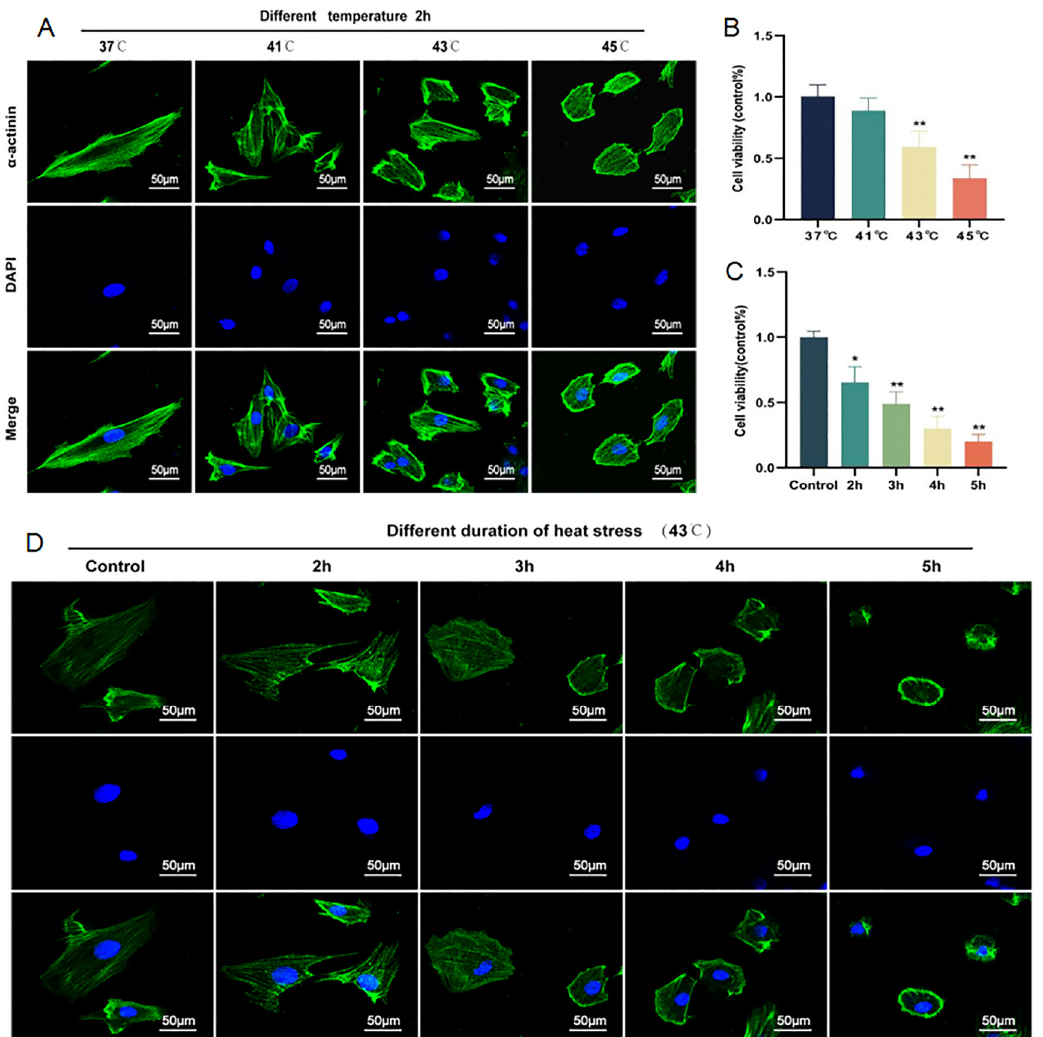
Figure 1. Morphological and viability changes in H9C2 cells. Cell morphology of H9C2 cells at different temperatures (37 °C, 41 °C, 43 °C and 45 °C) for 2 h. Scale bars = 50 µm. ( A ). Cell viability of H9C2 cells at different temperatures for 2 h via a CCK-8 assay ( B ). Cell viability of H9C2 cells at 43 °C for different duration (2 h, 3 h, 4 h, and 5 h) via a CCK-8 assay ( C ). Cell morphology of H9C2 cells at 43 °C for a different duration. Scale bars = 50 µm. ( D ). The staining was performed by FITC-conjugated α -actinin and DAPI and observed by confocal fluorescence microscopy. The results were expressed as the mean ± SD deviation of four or six independent experiments, * p < 0.05, ** p < 0.01 vs. the control group.